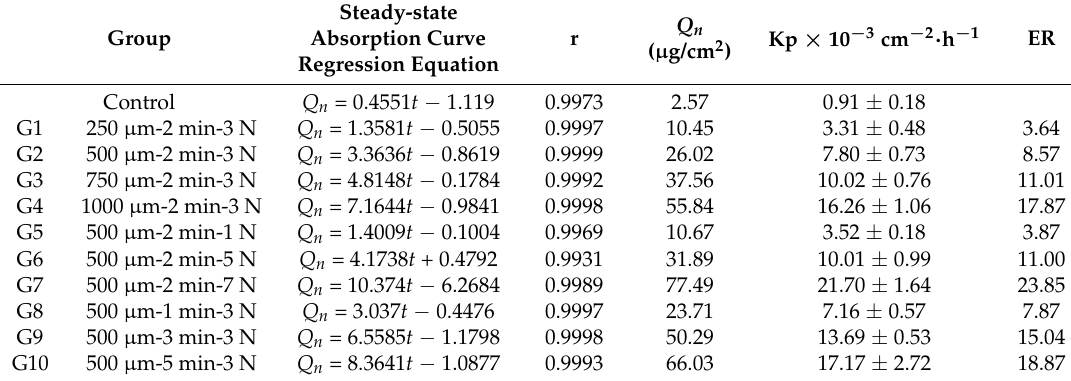
Table 6. Kinetics equations of Pae ex vivo skin permeation exposed to different MN conditions. Steady-state Absorption Group